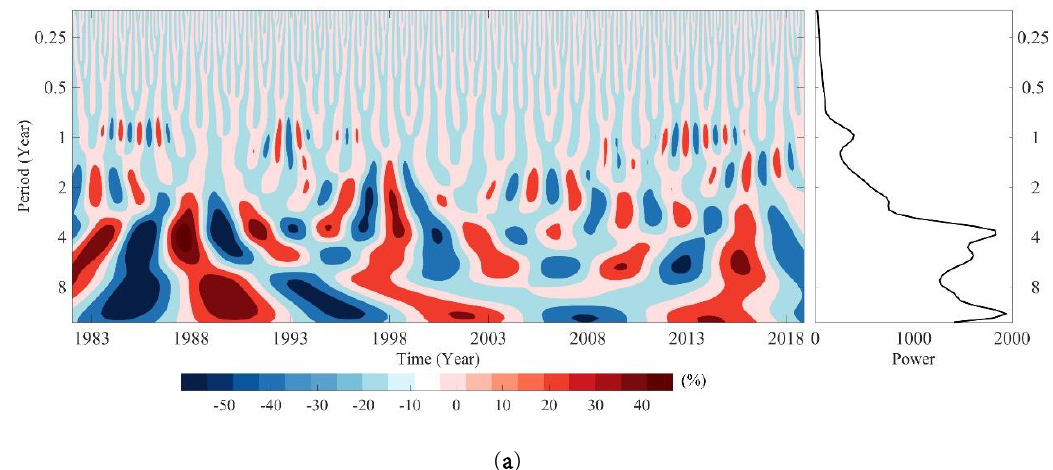
Figure 7. Wavelet transform spectrum and corresponding mean power of ( a ) Size variation; ( b ) Zonal center movement; ( c ) Meridional center movement; ( d ) Maximum SST; ( e ) Mean SST of the IW.